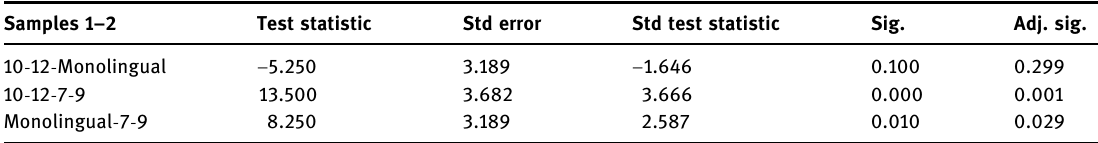
Table 2: Case Summary: Each row tests the null hypothesis, that is, the distribution of Samples 1 and 2 is the same. The asymptotic signi fi cance ( two - sided tests ) is displayed. The signi fi cance level is set at